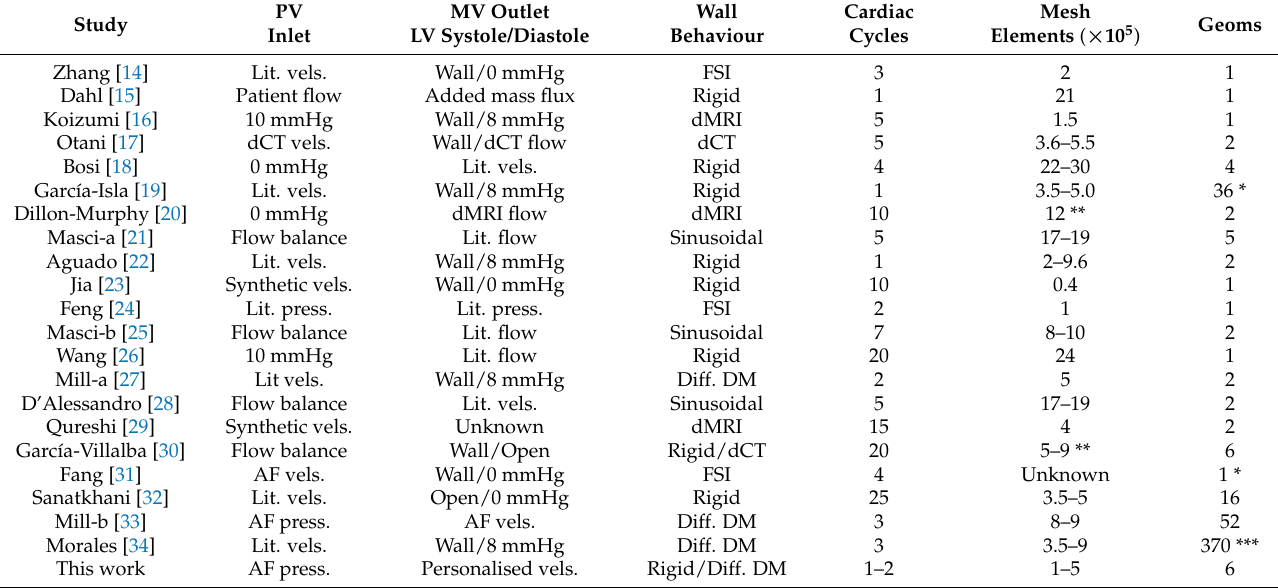
Table 1. Review of boundary conditions and different modelling choices for left atrial fluid simulations reported in the literature. PV: pulmonary veins; MV: mitral valve; geoms: number of geometries; lit: literature; vels: velocities; press: pressures; dCT/MRI: dynamic computed tomography/magnetic resonance imaging; diff. DM: diffusion-based dynamic mesh; FSI: fluid–structure interaction; * synthetic LA and realistic LAA geometries; ** estimated value from element size reported in the paper; *** 256 synthetic and 114 real